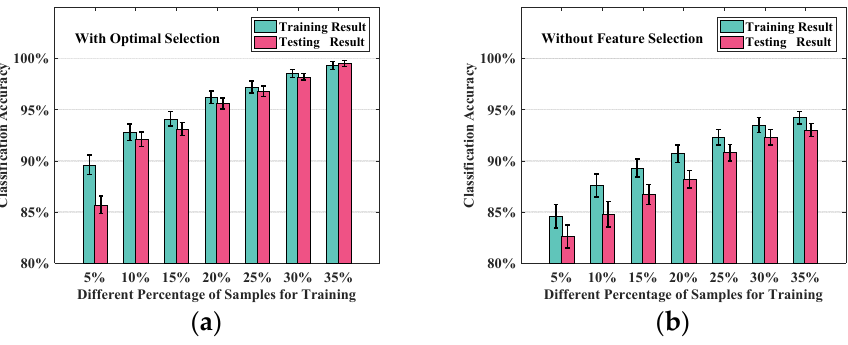
Figure 11. Accuracy comparison with different training percentages. ( a ) classification accuracy with feature heuristic selection; and, ( b ) classification accuracy without feature selection.